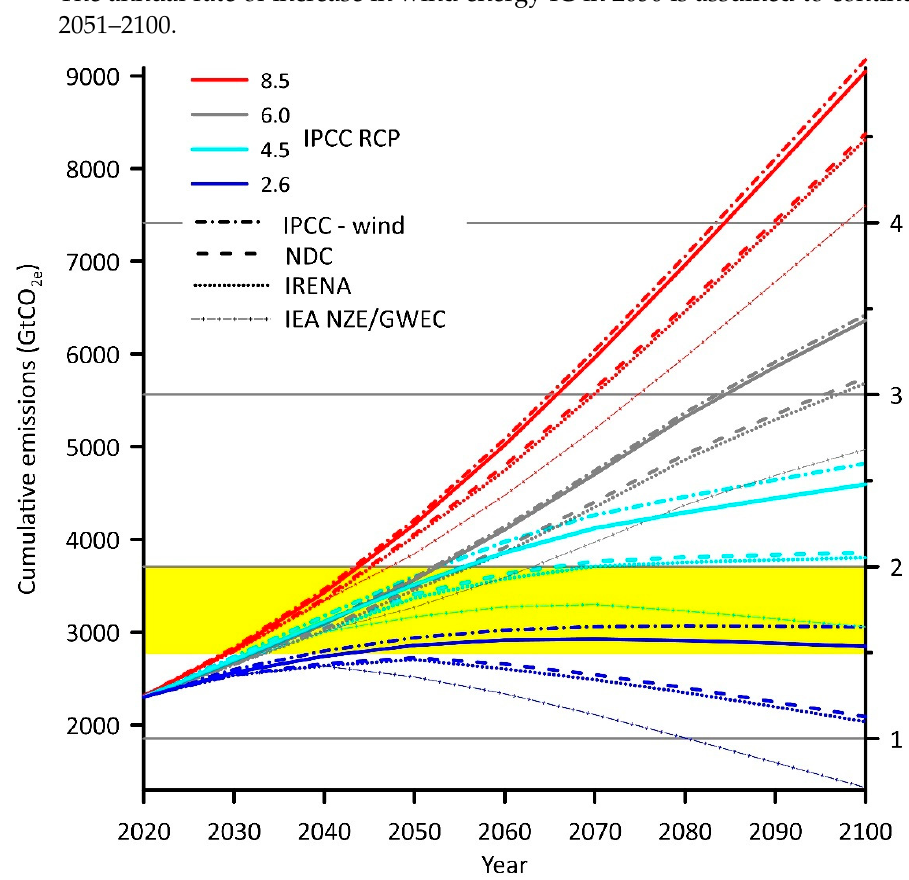
Figure 6. Projections of cumulative CO 2e emissions from the IPCC Representative Concentration Pathways [33] (IPCC RCP), minus the current contribution from wind energy (IPCC-wind). The right axis indicates the associated global temperature increase above pre-industrial levels. The scenarios for current pledges and targets (NDC), IRENA and IEA NZE/GWEC use avoided emissions from wind energy only with IPCC projected emissions. The goal of the Paris Climate Agreement is to limit Δ T to well below 2 °C, preferably to 1.5 °C [2] which is indicated by the horizontal bar in yellow.